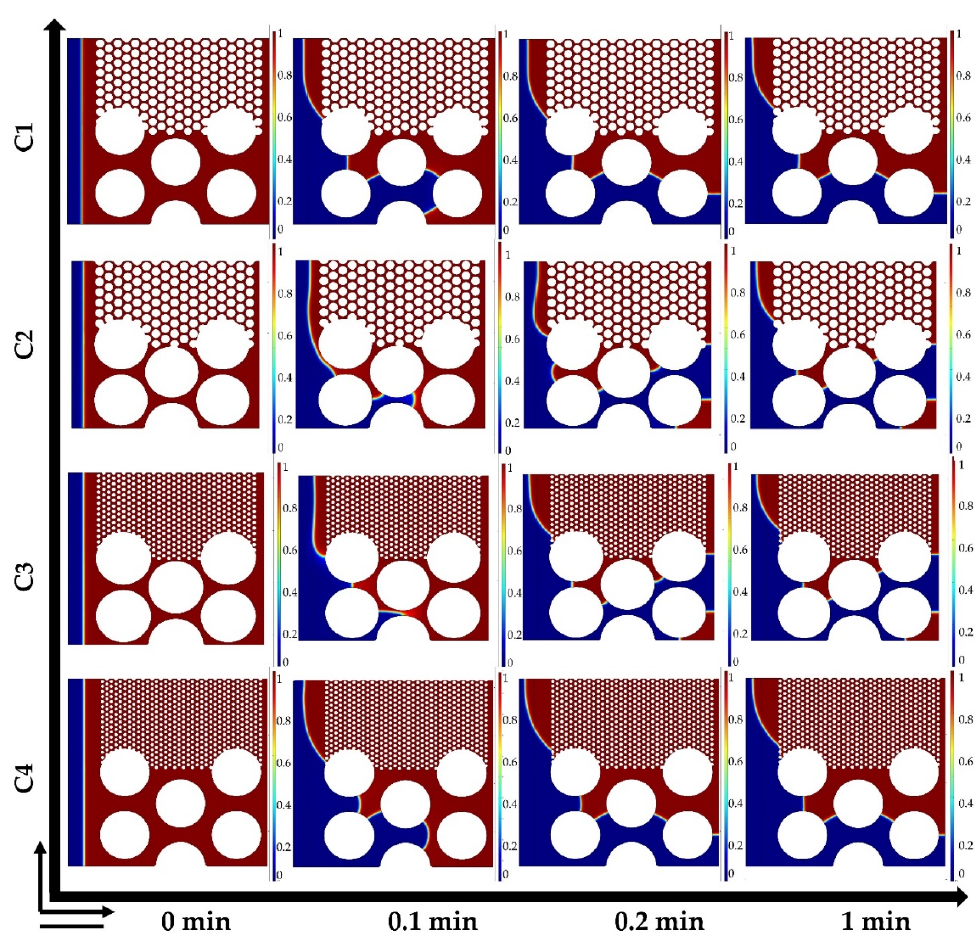
Figure 4. Change in oil volume fraction for chip 4 (from left to right: 0 min; 0.1 min; 0.2 min; 1 min; From top to bottom: C1; C2; C3; C4, C1 is short for chip 1, C2 is short for chip 2, C3 is short for chip 3, C4 is short for chip 4). The scale bar is 1 mm.